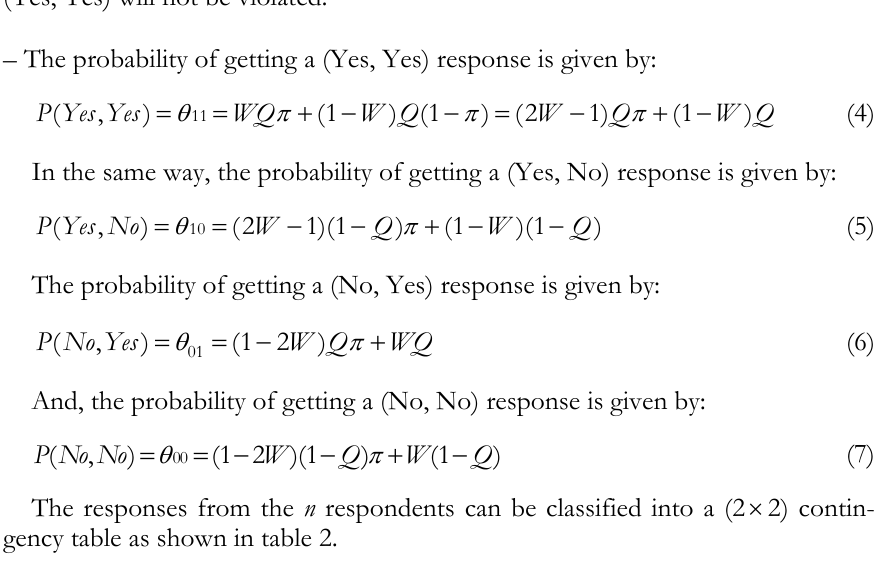
Classification of the responses from the two decks of cards